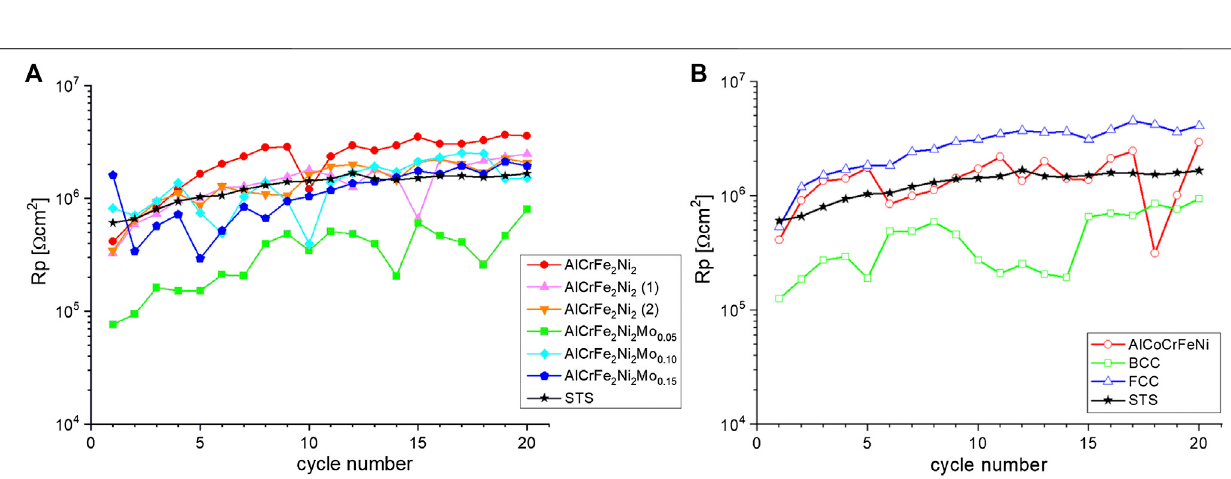
Frontiers in Materials |